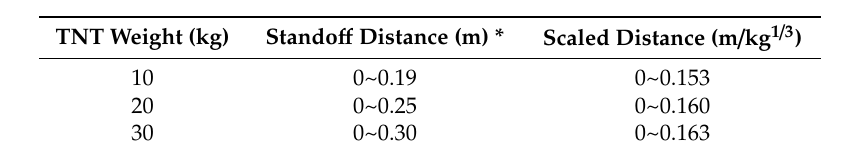
Table 2. Analysis